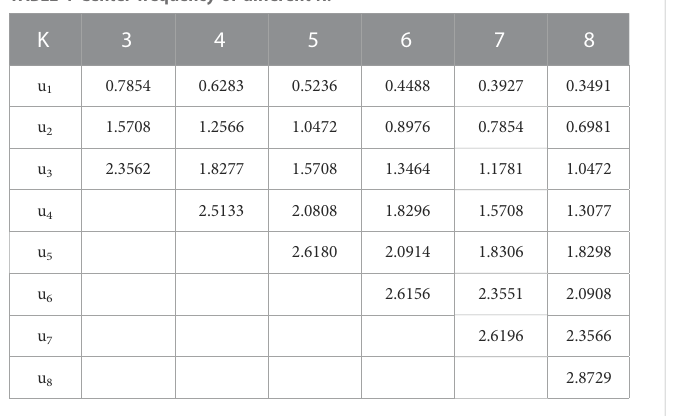
TABLE 1 Center frequency of different K .